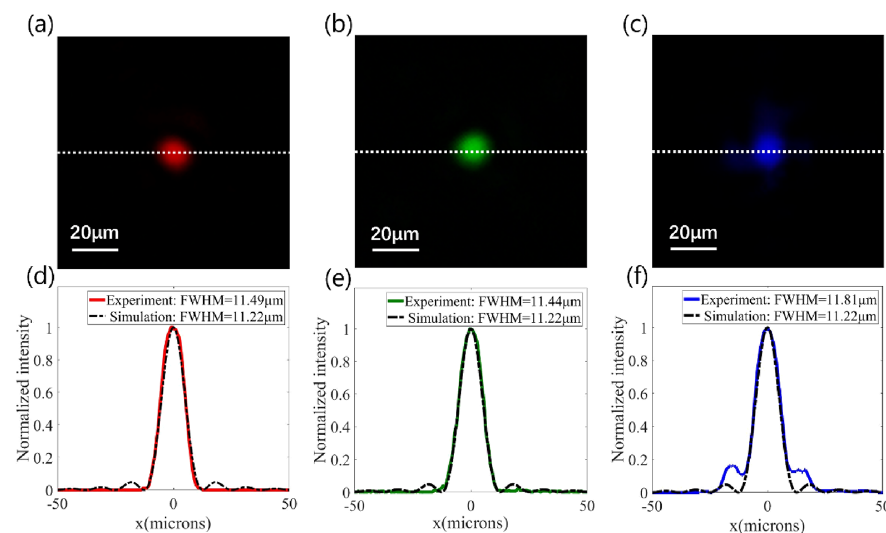
Fig. 4 Focal spots of the fabricated metalens with NA 0.035 at RGB illumination and comparison with = simulation results. ( a to c ) Measured focal spot intensity profile at the illumination wavelengths of ( a ) 633 nm, ( b ) 532 nm and ( c ) 457 nm. ( d to f ) Corresponding normalized intensity profiles along the white dashed lines in ( a to c ) respectively and comparison with simulation results based on Rayleigh‑Sommerfeld diffraction. FWHMs of both the experimental and simulated results are labeled in the